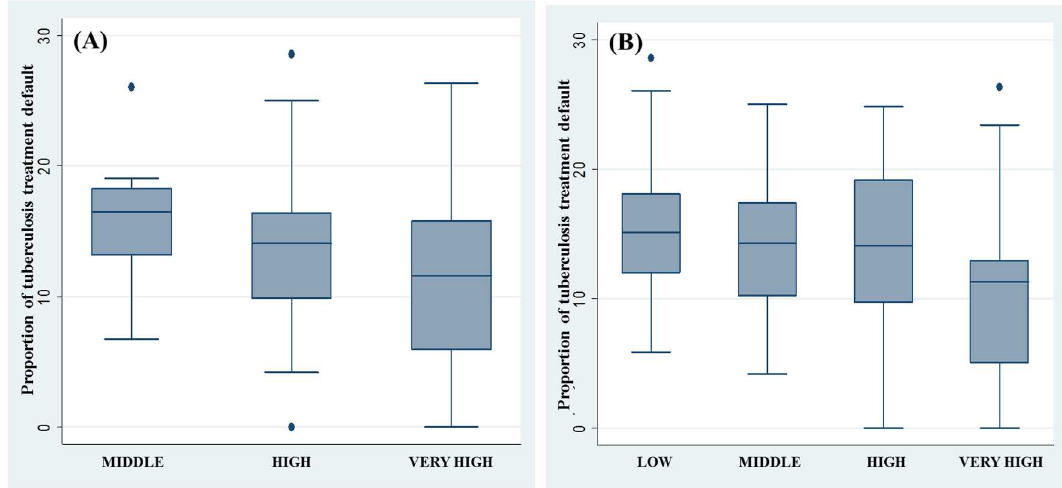
Fig 3. Boxplot of the proportion of non-adherence to antituberculosis treatment by strata of socioeconomic status: (A) human development index and (b) social development index.